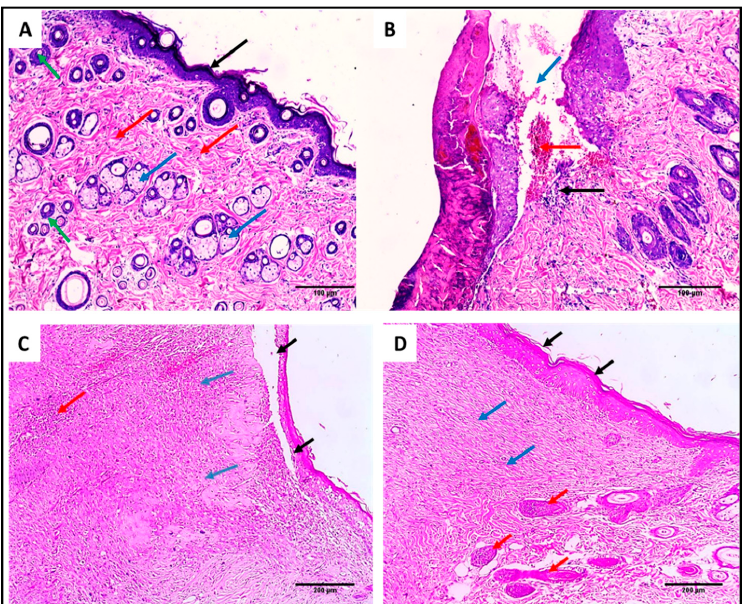
Figure 13. H&E-stained wound sections of ( A ) section in normal skin showed normal epidermal thickness (black arrow), with underlying dermis showing thick collagen bands (red arrows), hair follicles (green arrows), and sebaceous glands (blue arrows) (×200). ( B ) Section in the wound of the control group showed an ulcer (blue arrow) filled with hemorrhage (red arrow) and acute and chronic inflammatory cellular infiltrate (black arrow) (×200). ( C ) Section in the Betadine™-treated group showed partial epithelization (black arrow) with underlying granulation tissue (blue arrows) with little inflammatory cellular infiltrate (red arrow) (×200). ( D ) Section in the AgNPs-treated group showed complete epithelization (black arrows) with underlying focal granulation tissue formation (blue arrows) with adjacent proliferating hair follicles (red arrows) without inflammation (×200). Light microscopy of Masson’s trichrome-stained wound sections was used to inspect the collagen fibers (Figure 14). The percentages of the collagen fibers in the Betadine™- and AgNPs-treated groups were significantly higher than the control group.